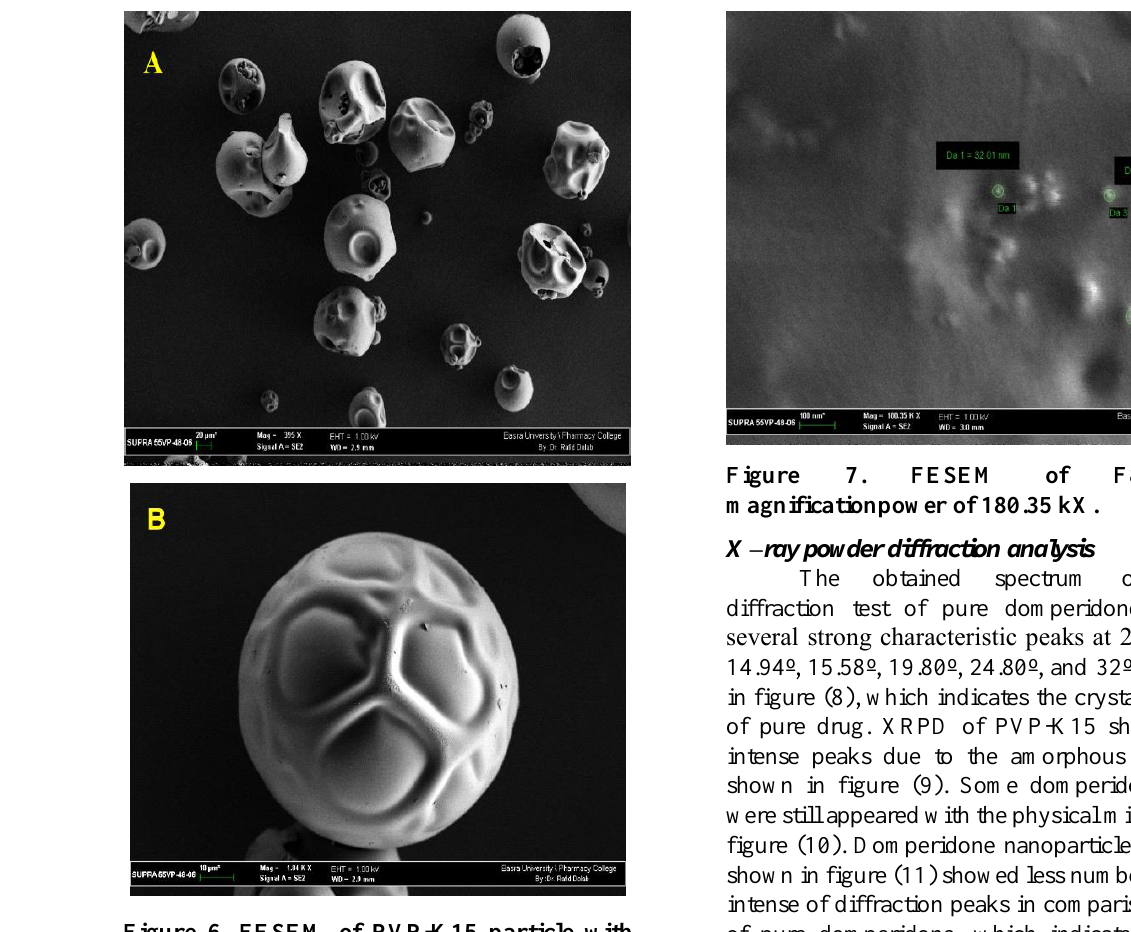
Figure 6. FESEM of PVP-K15 particle with magnification power of A-395X and B-1.84kX.